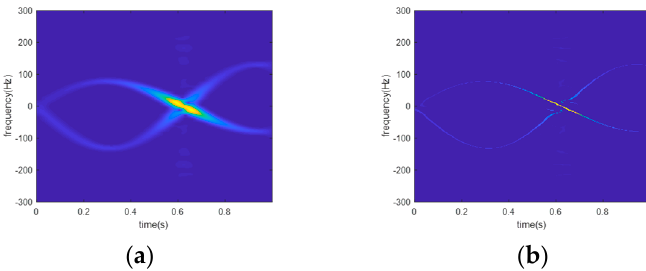
Figure 2. Time-frequency (TF) representations of cone-shaped target. ( a ) Short-time Fourier transform (STFT); ( b ) synchroextracting transform (SET).